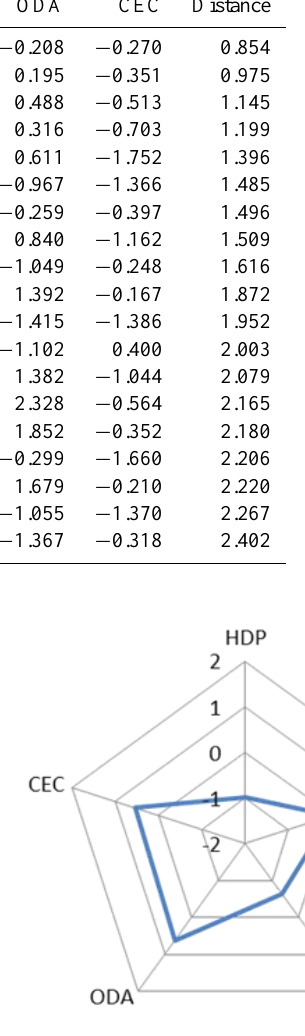
Fig. 8. Profile 4 – mean feature of this profile is the important level of External Aid (ODA) facilitated by a relatively good political ac- countability and stability (CEC) despite a low human development (HDP). In line with this general context, access to WSS is still be- low the MDG’s targets.